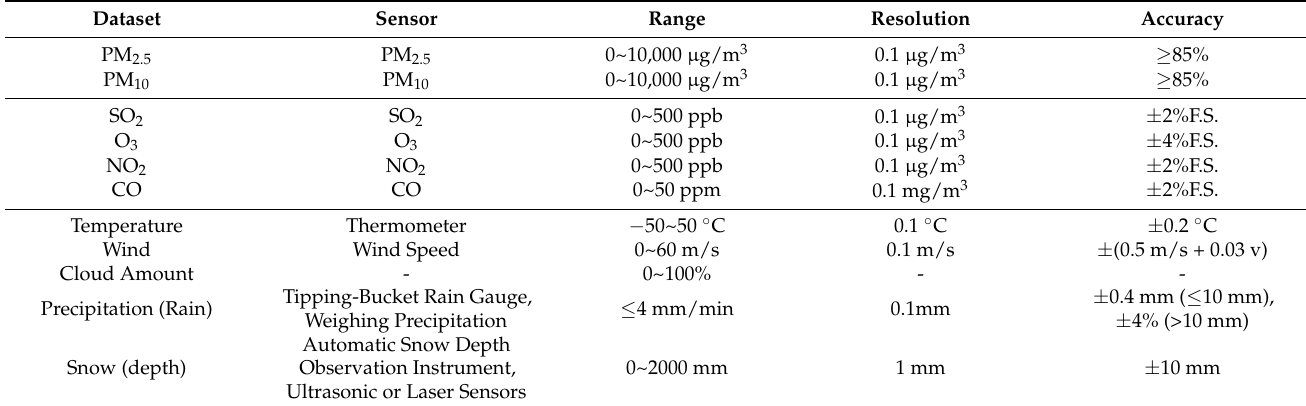
Table 4. Parameters and specifications of the sensors to collect